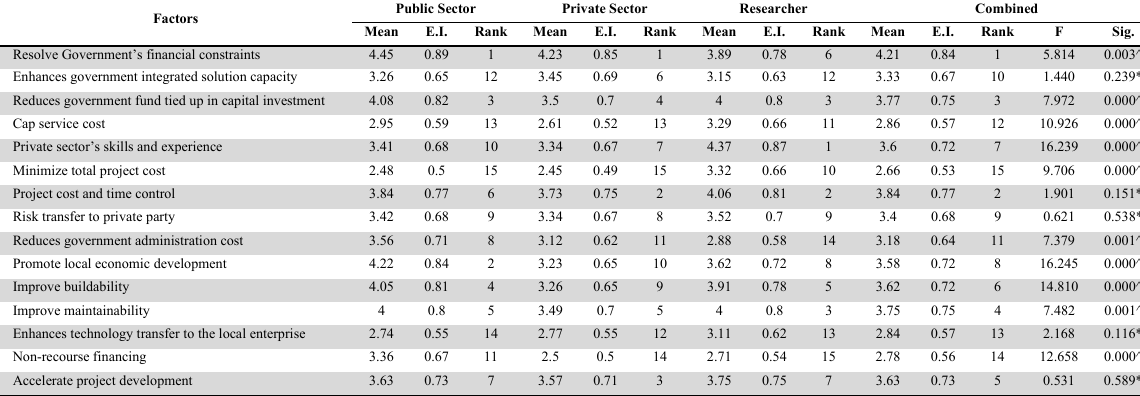
Group wise Mean Rank and E.I. of Attractive